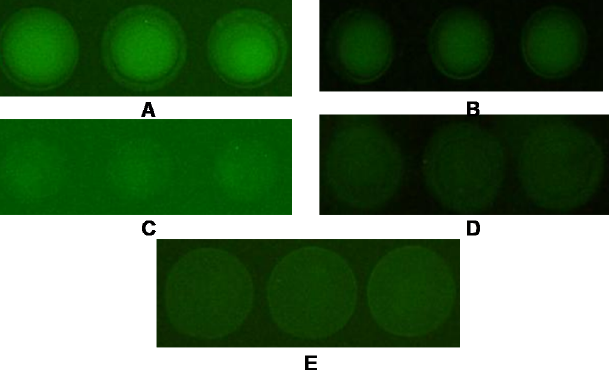
Figure 2. The scanned image of different substrates. ( A ) polymer slide G; ( B ) Superfrost Plus slide; ( C ) aldehyde slide; ( D ) poly-lysine slide; ( E ) agarose surface-modified slide.